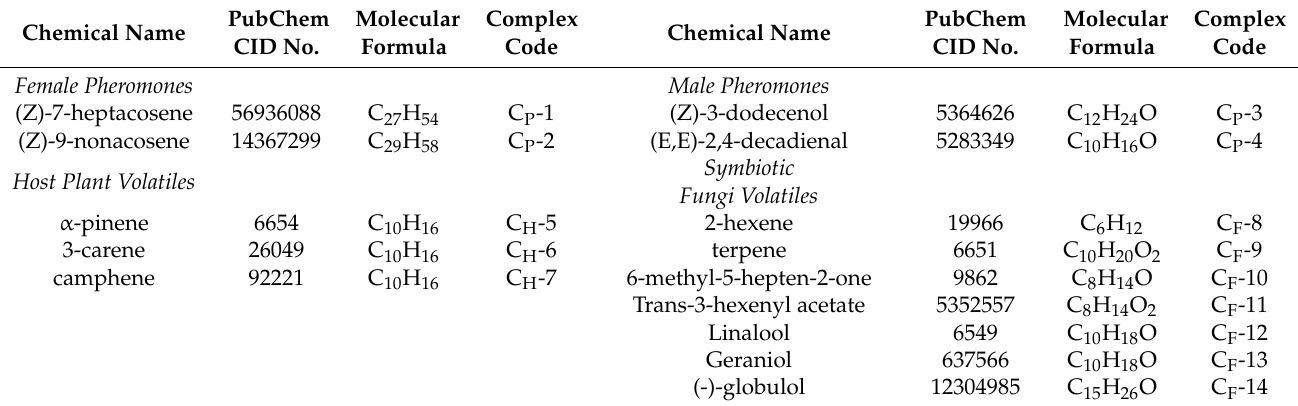
Table 2. Odor compound information used in